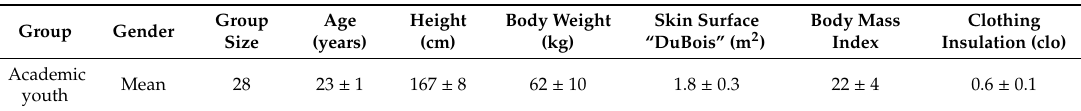
Table 2. Anthropometric data of tested panel groups with expanded uncertainty at the confidence level of 1 − α =